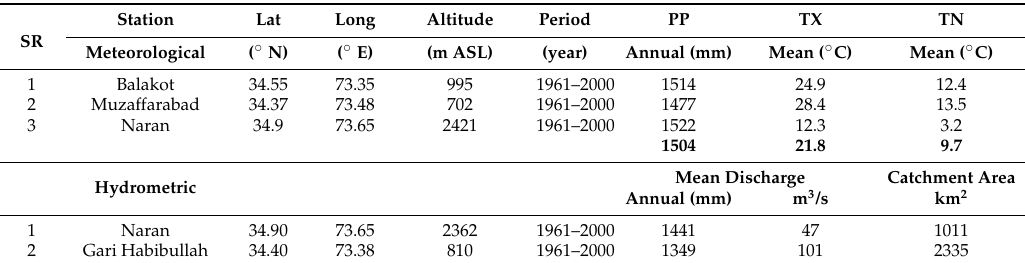
Table 1. Basic information about hydro-climatic stations in the Kunhar River